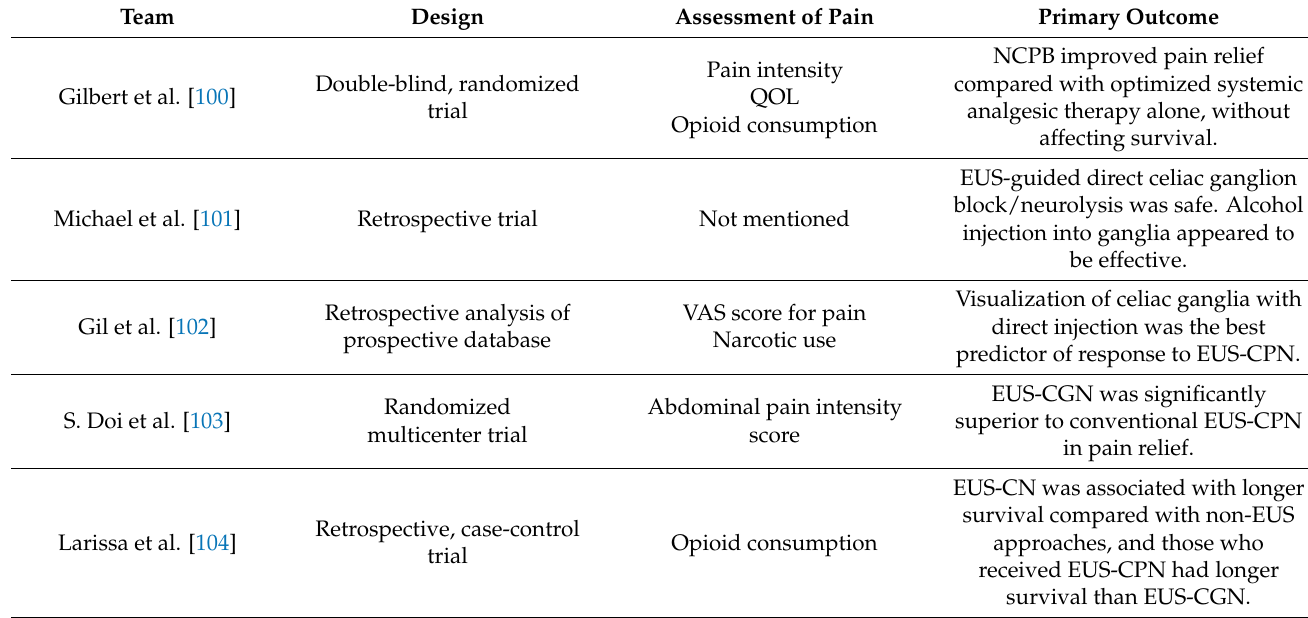
Table 4. Clinical trials of pain management in human pancreatic